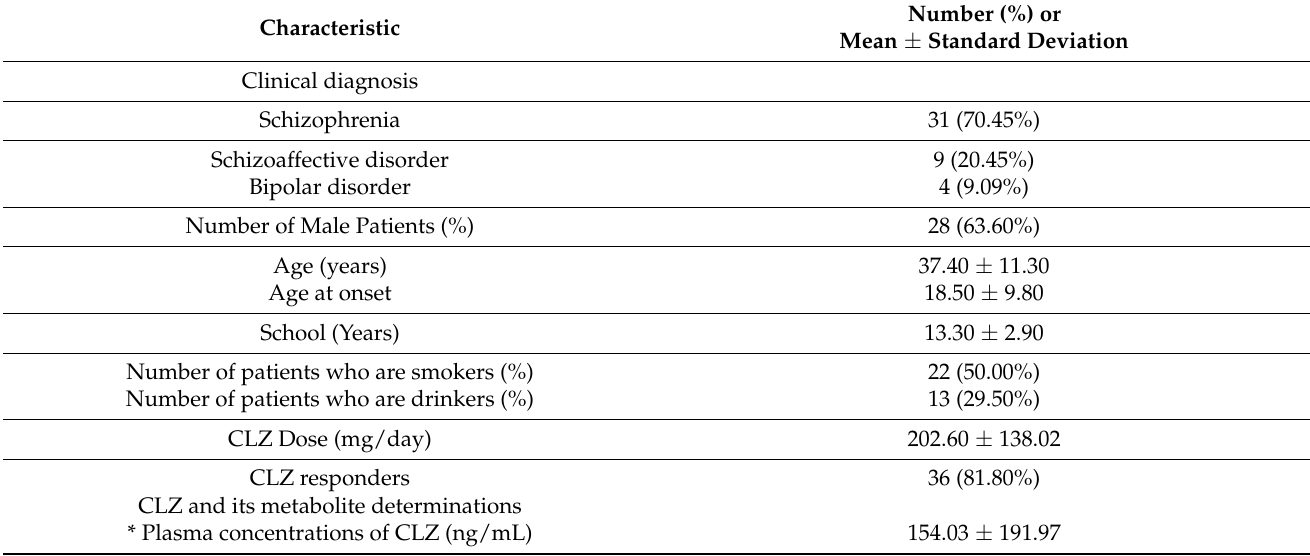
Table 1. Clinical and demographic characteristics of clozapine-treated patients ( n =